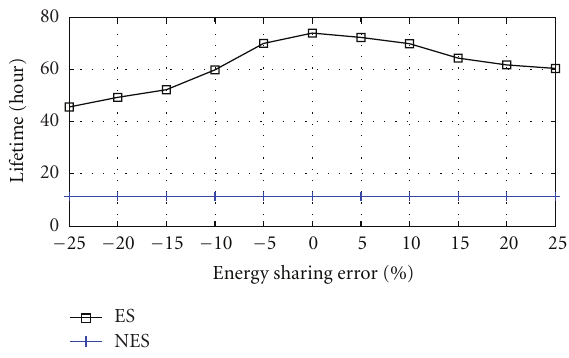
Figure 14: Harvested power versus time.